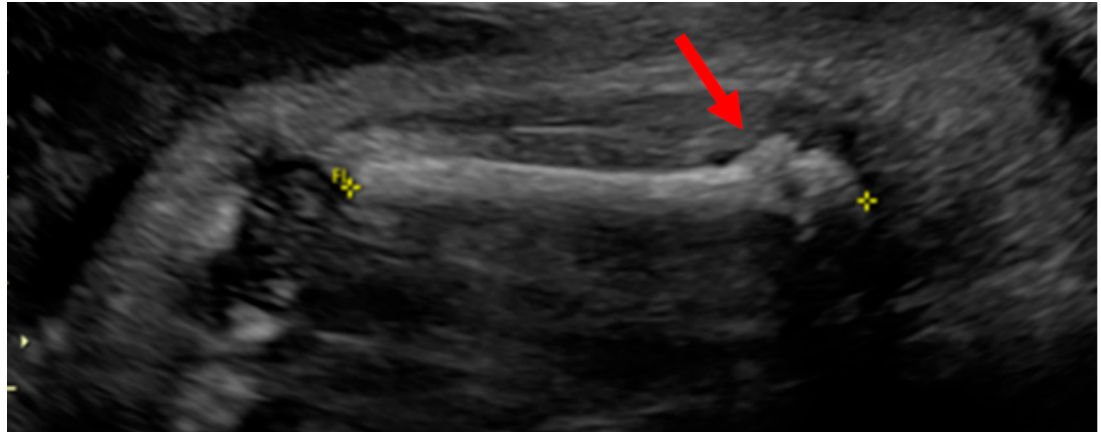
Figure 3. There was angulation at the femoral metadiaphysis bilaterally with callus formation at the metadiaphysis of the left femur (arrow, Figure 3). Holick MF, copyright 2021.